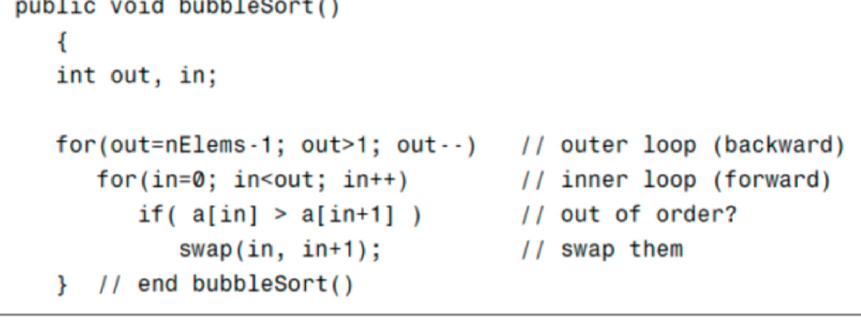
Figure 2. Bubble Sort.